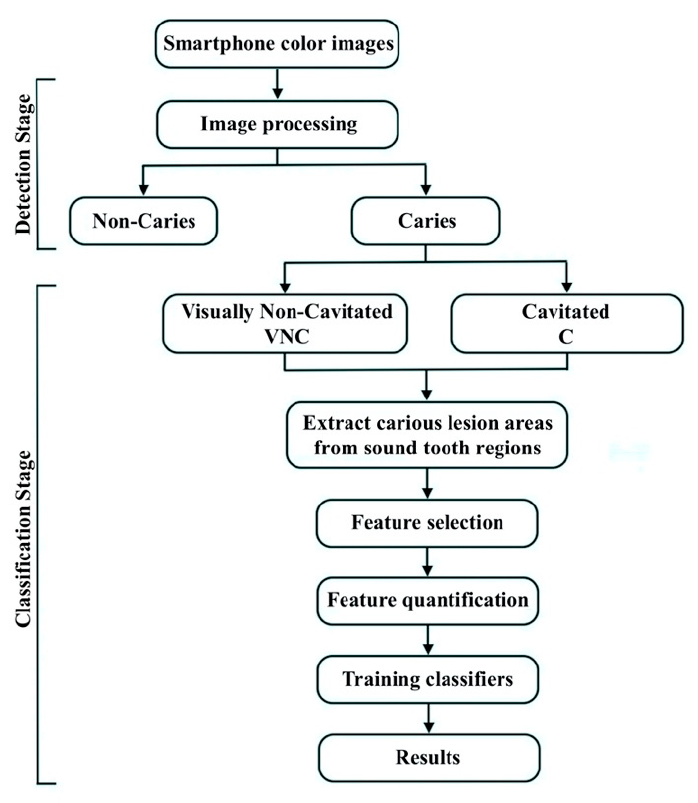
Figure 1. Schematic representation of the proposed system.